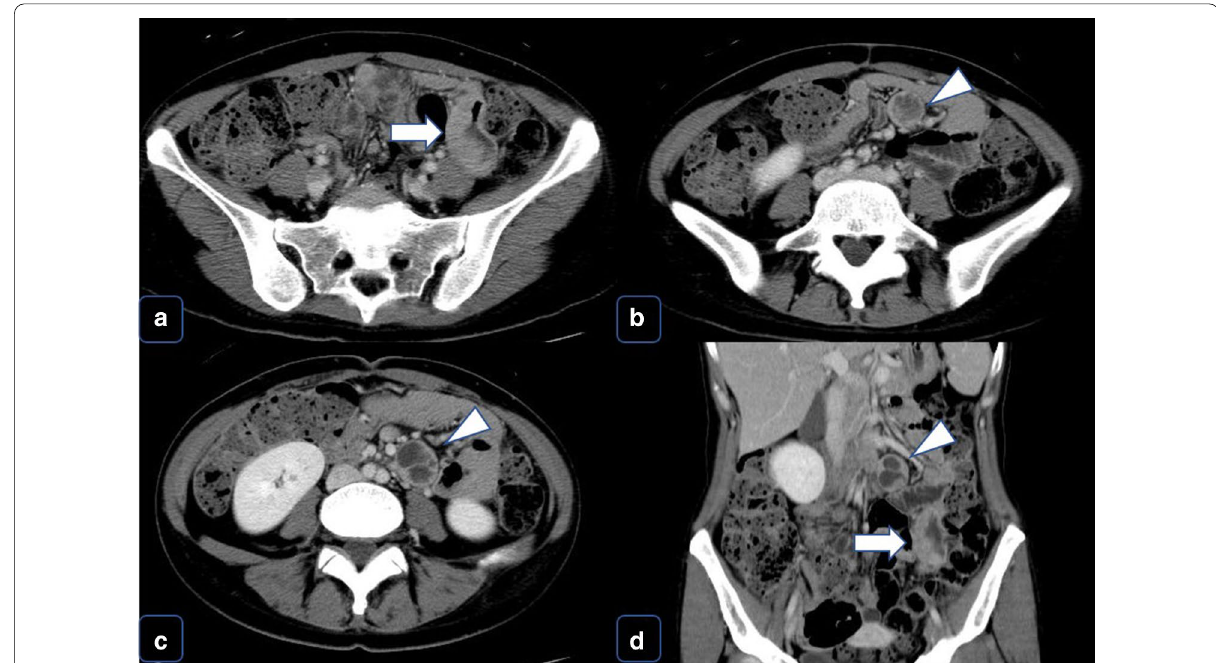
Fig. 1 CT findings. a Horizontal view. Primary tumor (the white arrow). b , c Horizontal view. Lymph nodule (the arrowhead). d Sagittal view. Primary tumor (the white arrow) and lymph nodule (the